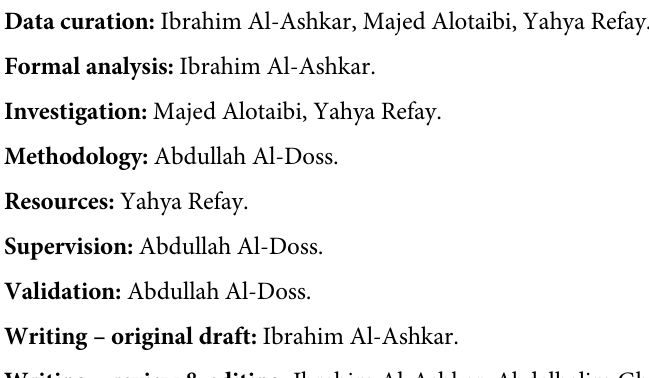
S2 Table. Microsatellite (SSR) markers used in this study and location on the chromosome. Markers in bold are specific SSR markers linked to earliness or yield and yield components in wheat. S3 Table. Mean performance of 28 F hybrid combinations and their respective parents for 1 days to heading, grain filling duration, and grain yield for each and across